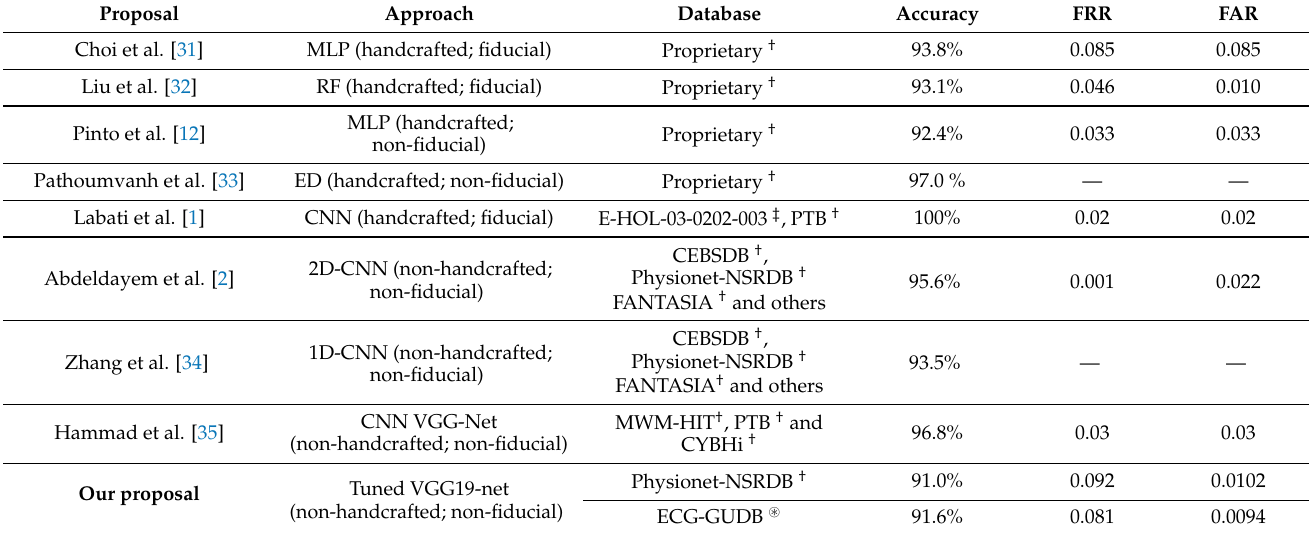
Table 2. A comparative analysis of ECG-based identification